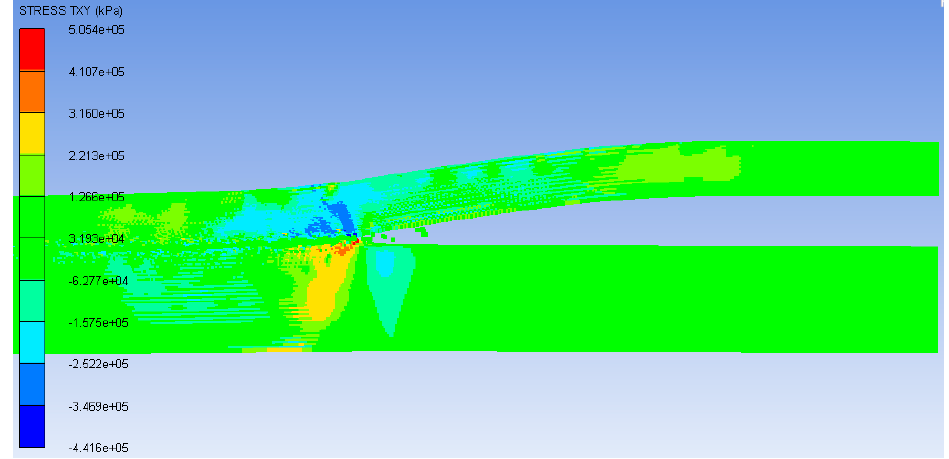
Figure 9. The contour of shear stress distribution.